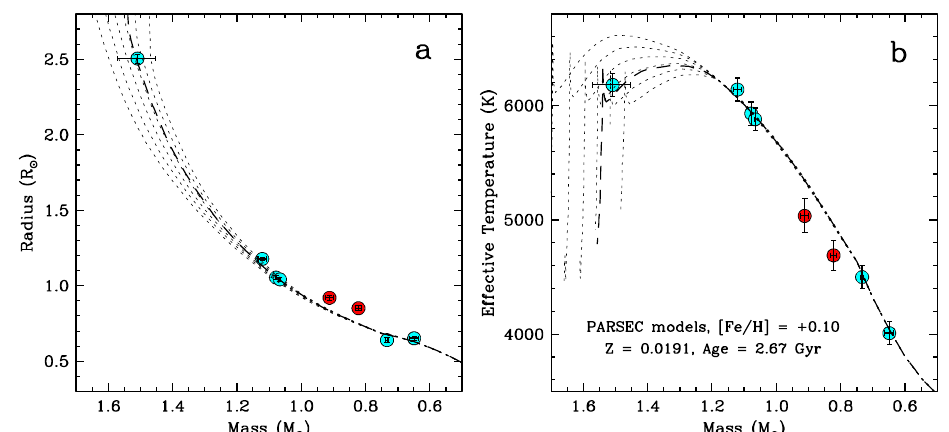
Figure 1. Comparison of measurements for four Ruprecht 147 eclipsing binaries against model isochrones from the PARSEC 1.2S series by [22] for the measured composition of the cluster ( [ Fe/H ] = + 0.10, Z = 0.0191 in these models). EPIC 219511354 is marked in red and deviates from the best fit. ( a ) Mass vs. radius diagram. Dotted lines represent isochrones from 2 to 3 Gyr in steps of 0.2 Gyr, from the bottom up. The best-fit isochrone with an age of 2.67 Gyr according to these models is indicated with a dashed line. ( b ) Mass vs. effective temperature diagram, with the same isochrones as in the previous